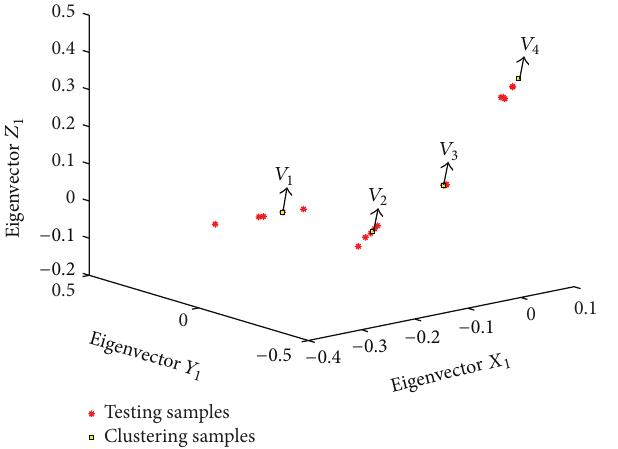
Figure 12: Space distribution of test samples and clustering